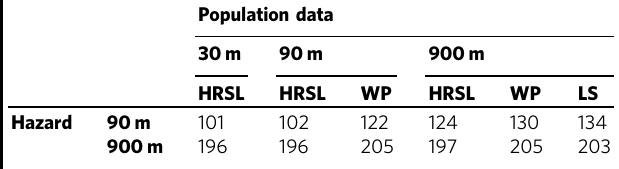
Table 2 Total population living in the 1 in 100 year fl oodplain (millions) summed across all 18 countries, for varying resolutions of both hazard and population